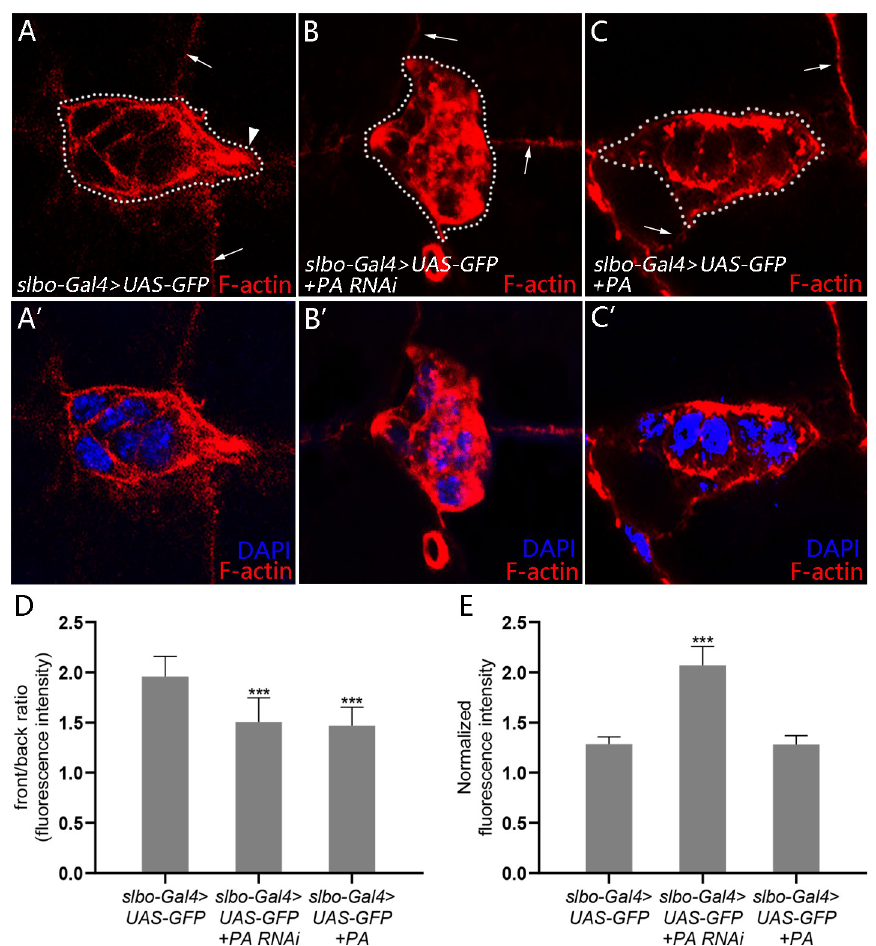
Fig 3. RhoGAP18B-PA is required for F-actin organization in border cell cluster. (A-C’) Confocal micrographs of control, PA knockdown and PA overexpression egg chambers labeled with phalloidin (red) for F-actin and with DAPI (blue) for nuclei. Border cell clusters are marked by dotted lines and their movement direction is from the left to the right. F-actin protrusion is indicated by an arrowhead. Membrane F-actin staining between nurse cells is indicated by arrows, which is used for normalization of fluorescence in quantification of (D). (A, A’) A slbo > GFP border cell cluster shows a polarized distribution of F-actin staining at the front. (B, B’) A slbo > GFP+PA RNAi border cell cluster shows reduced polarity of F-actin distribution and elevated F-actin level. (C, C’) A slbo > GFP+PA border cell cluster shows reduced polarity of F-actin distribution. (D) Quantification of F-actin staining front/back ratio of control, PA knockdown and PA overexpression border cell clusters ( ��� P < 0.001, t = 6.46, t test, n = 20; ��� P < 0.001, t = 8.08, t test, n = 20). See Materials and methods for details. (E) Quantification of normalized F-actin staining of control, PA knockdown and PA overexpression border cell clusters ( ��� P < 0.001, t = 17.26, t test, n = 20). See Materials and methods for details. Results are presented as mean ±